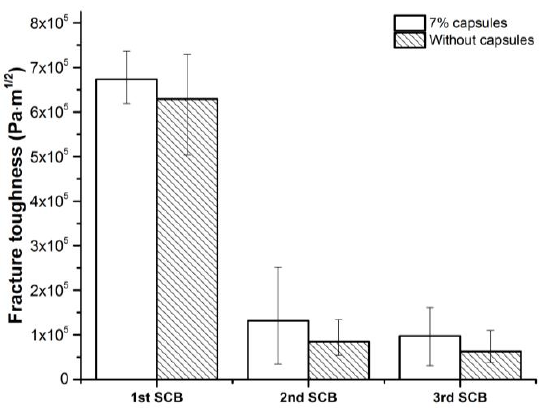
Figure 12. Fracture toughness of SCB specimens.